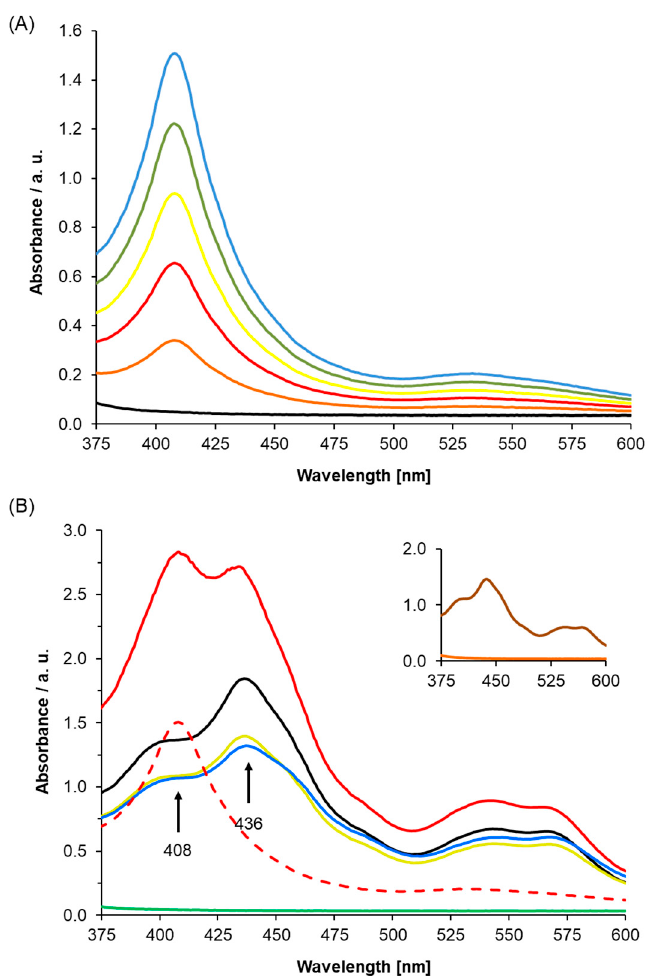
Figure 2. ( A ) UV/Vis spectrum of purified Light Response Bric-a-Brac/Tramtrack/Broad Complex (AtLRB3) under oxidizing conditions. The protein shows a distinct Soret peak at 408 nm, which is concentration-dependent (black: buffer F, blue–orange: AtLRB3 at 89/71/53/36/18 µg/mL). ( B ) Absorption spectra were measured after adding hemin to the purified folded protein (89 µg/mL) and unfolded protein (500 µg/mL) as a control (green: unfolded AtLRB3 without excess hemin, blue: unfolded AtRLB3 + hemin, red: heme reconstituted AtLRB3 + excess hemin, black: hemin in buffer F, light green: hemin in buffer C, dotted red: AtLRB3 without excess hemin). Hemin in both buffers (free hemin) showed Soret peaks at 436 nm, which were different from the Soret peak at 408 nm of hemin protein. Unfolded protein with added hemin shows an absorption peak similar to hemin in buffer alone (buffer compositions as described in the method). Inset: BSA (1 mg/mL) (orange) and BSA with added hemin (brown) as a negative control.